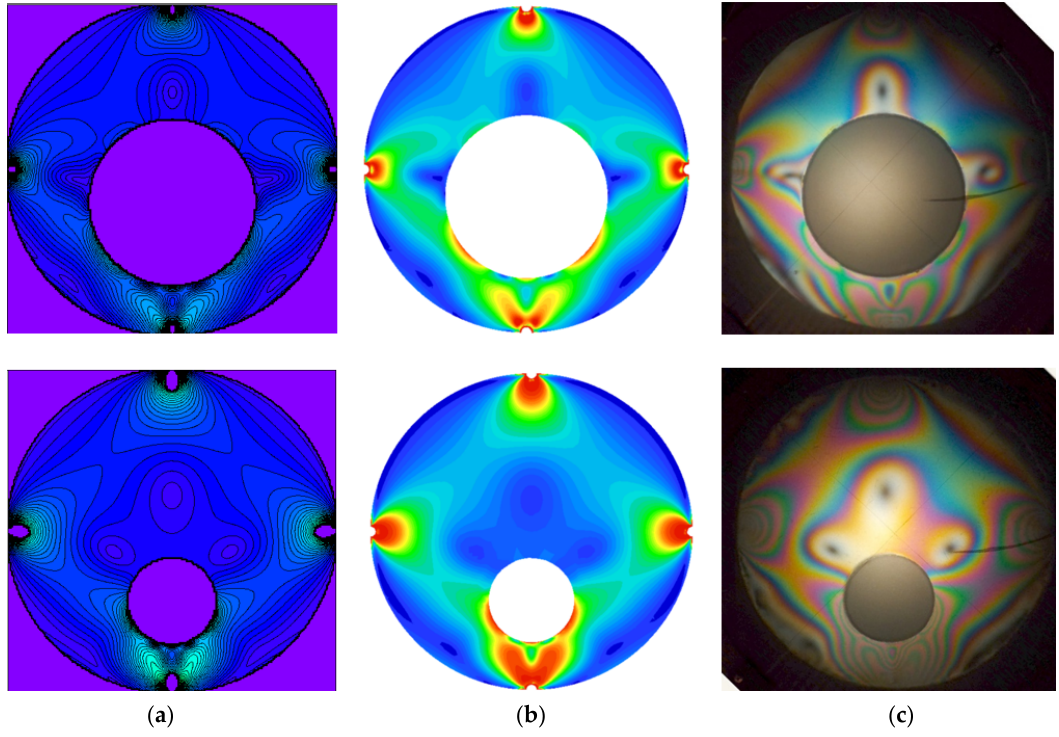
Figure 19. Isochromatic fields for the two geometries of the ring compressed by four equidistant forces (loading Case e, Table 1): theoretical ( a ), numerical ( b ) and experimental ( c ) results.